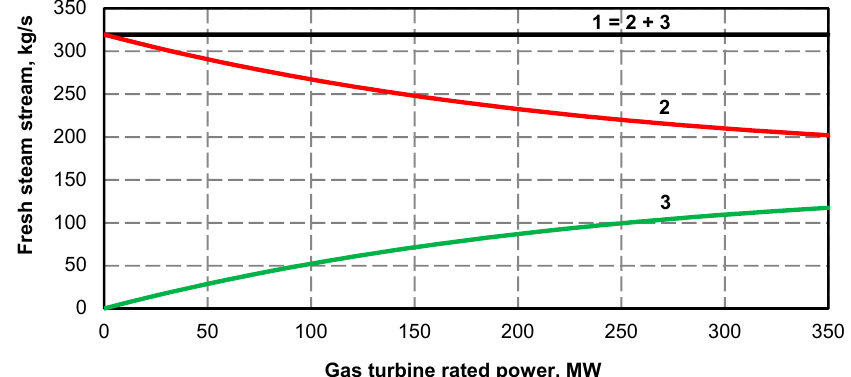
Figure 12. Fresh steam streams as a function of gas turbine rated power: 1—maximum fixed steam stream of 319.4 kg / s fed to the steam turbine 2—steam stream generated in the steam boiler, 3—steam stream generated in the recovery boiler.